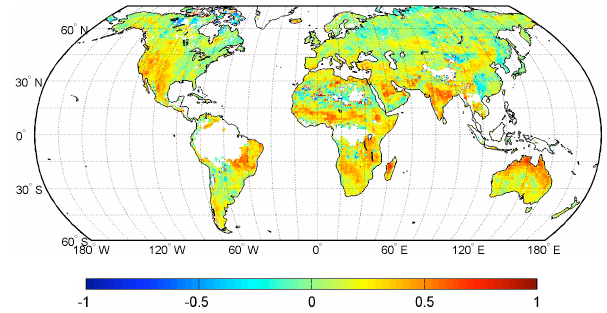
Fig. 2. Global Pearson’s correlation coefficient maps of AMSR-E versus the CRU-NCEP precipitation forcing of